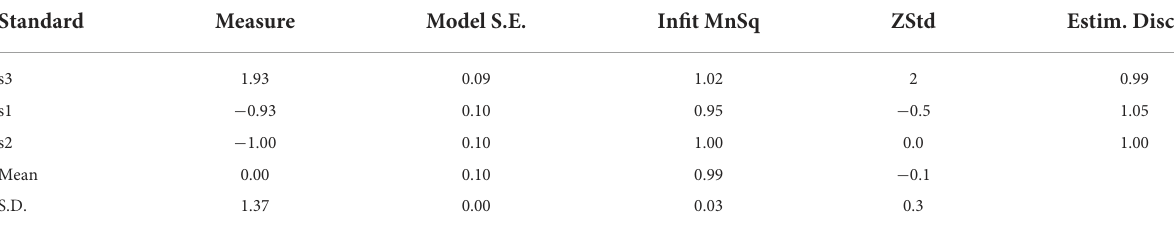
TABLE 5 Results of rating scale level analysis.